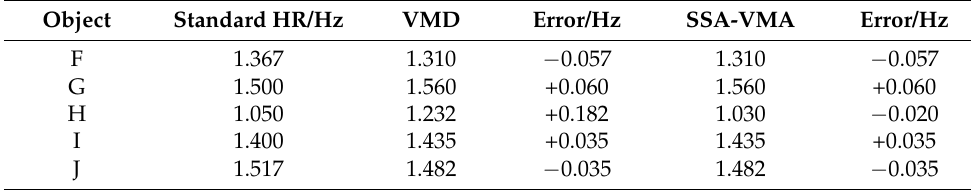
Table 4. Experimental comparison results at 1.2